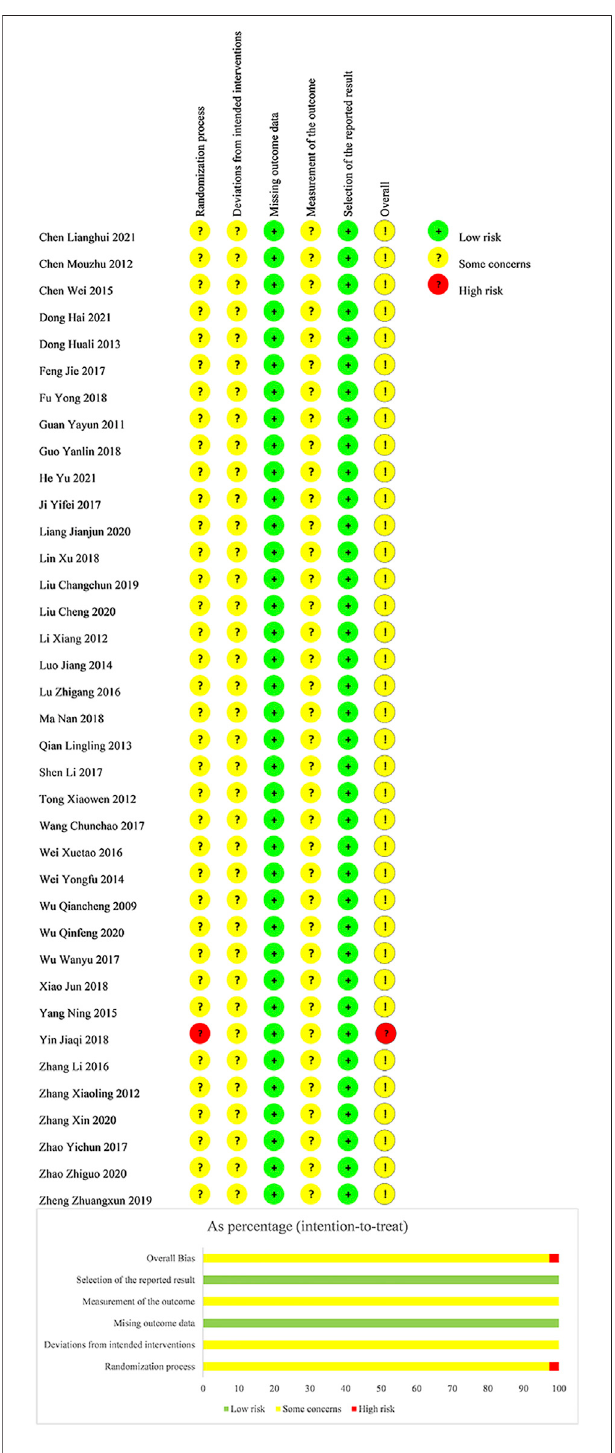
FIGURE 2 | Risk of bias of included